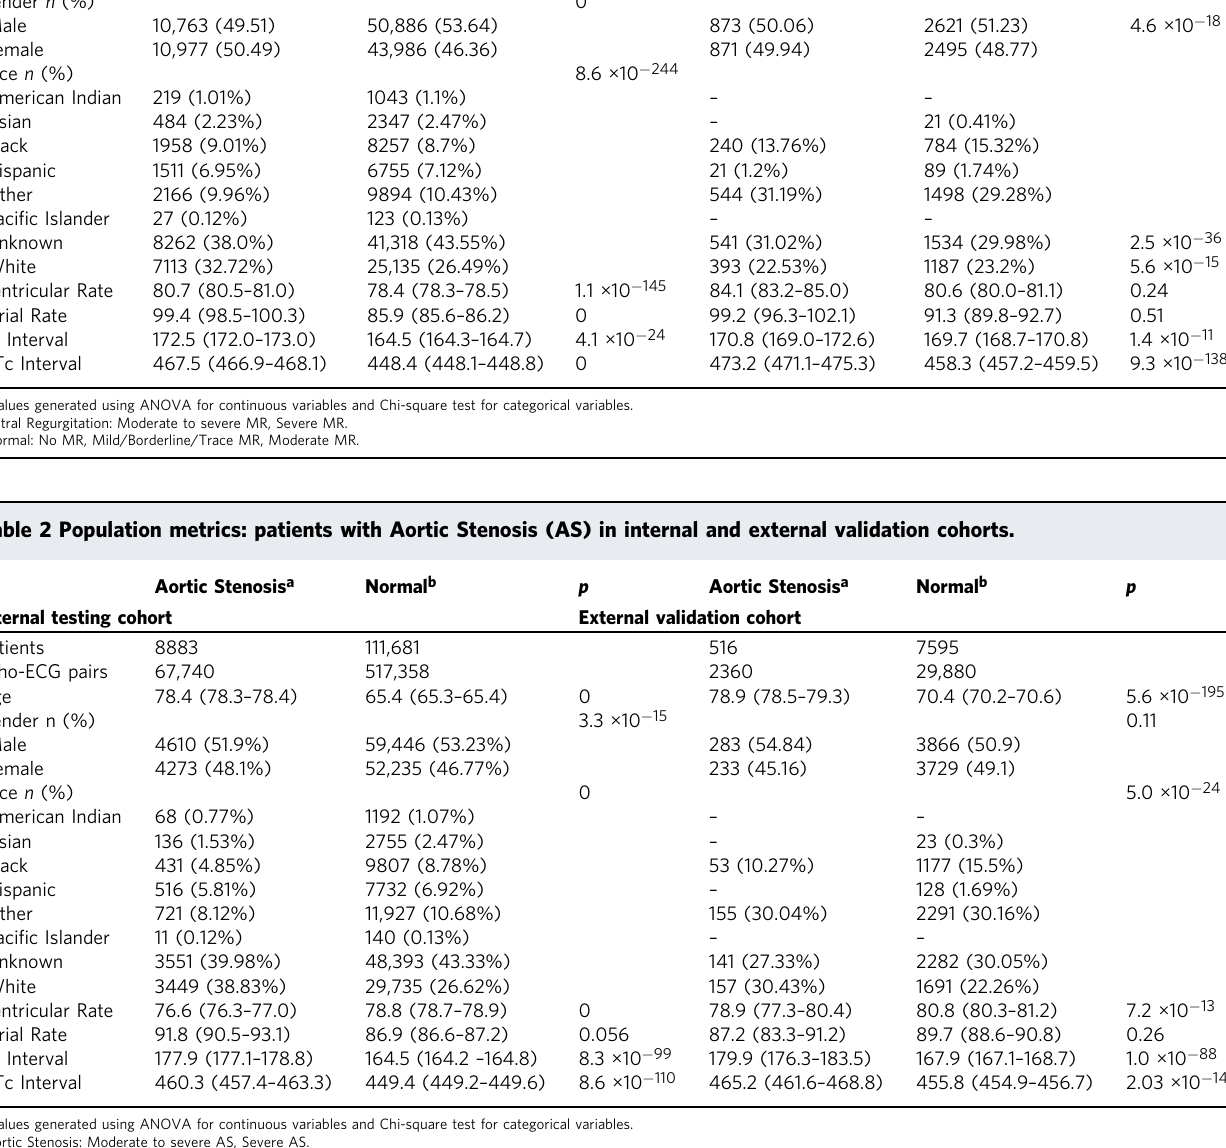
p -values generated using ANOVA for continuous variables and Chi-square test for categorical variables. a Aortic Stenosis: Moderate to severe AS, Severe AS. b Normal: No AS, Mild/Borderline/Trace AS, Moderate